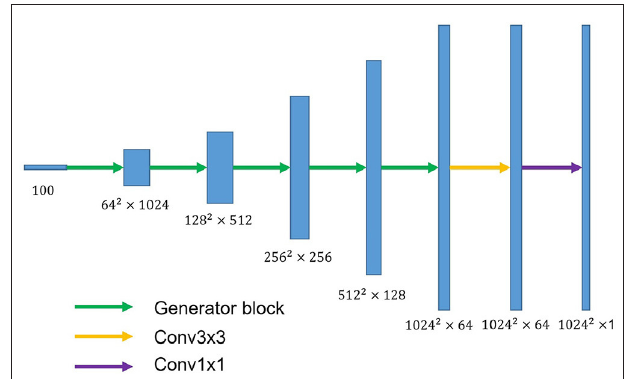
FIGURE 3 | The overall structure of the proposed generator. The generator block consists of a pointwise convolution layer and two 4 × 4 fractionally strided convolution layers. Conv3 × 3 denotes the 3 × 3 convolution layer. Conv1 × 1 represents the 1 × 1 convolution